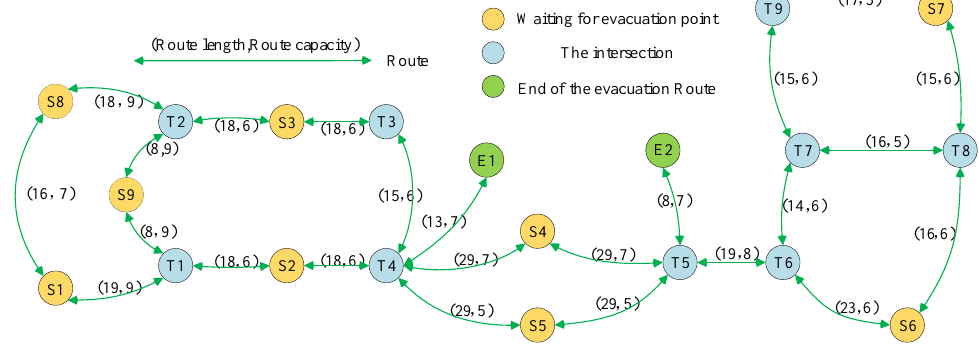
Figure 4. Second floor network topology diagram of the cruise ship.